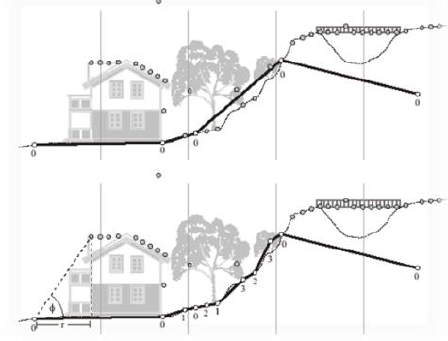
Figure 2. Progressive compression algorithm Axelsson. first estimate based on the minimum height of the bare ground in neighborhoods (above) and subsequent estimates based on the angle and distance to the nearest